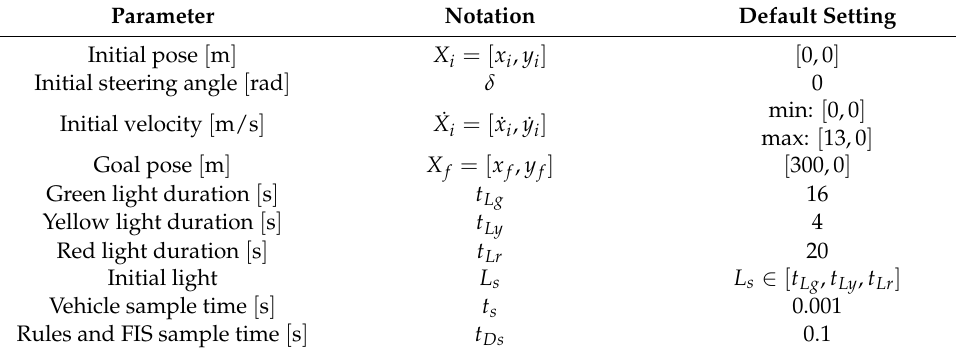
Figure 7. Road layout. Table 3. Environment